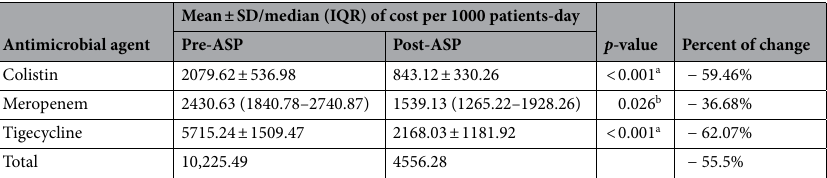
Table 2. Comparison of the mean/median costs of antimicrobial administration in the average value of Israeli Shekel during the two phases of the study (pre- and post-intervention). ASP antibiotic stewardship program, SD standard deviation, IQR interquartile range. a Analyzed using independent sample t-test. b Analyzed using the Mann–Whitney U